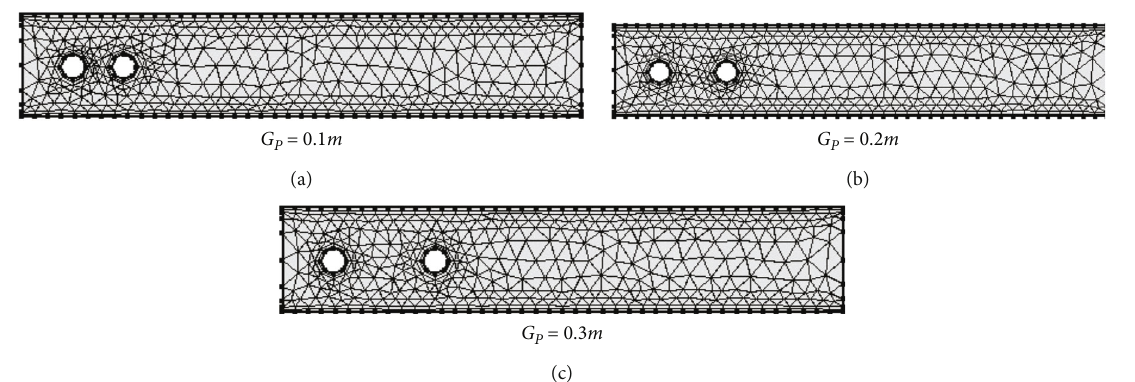
= 0 : 1 m . (b) G = 0 : 2 m . (c) G = 0 : 3 m . P P P